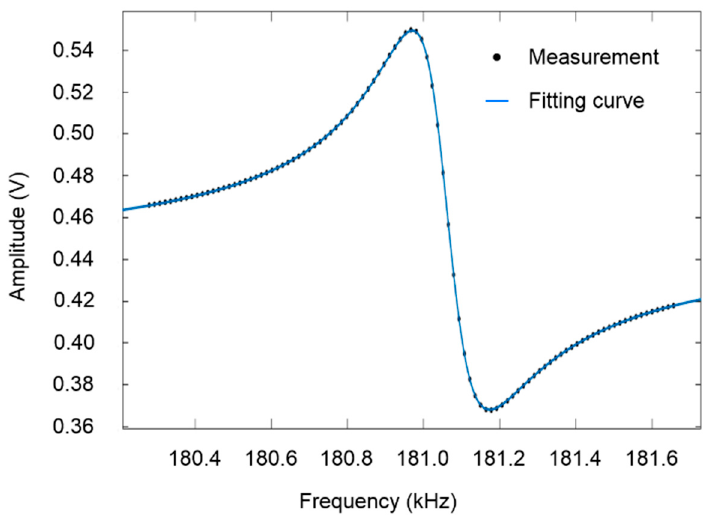
Figure 11. Fano fitting of a measured resonance response with asymmetric amplitude line shape of an electro-thermal piezoresistive cantilever with ZnO NRs and chitosan self-assembled